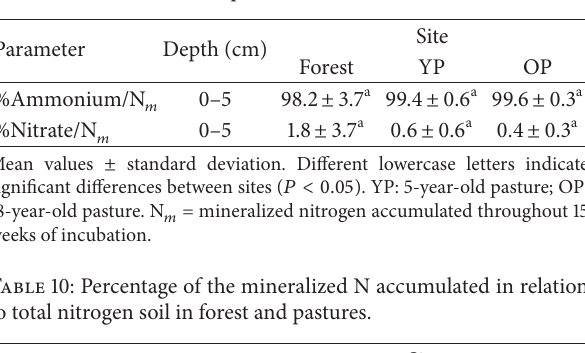
Table 9: Relationship between soil ammonium and nitrate in relationtothetotalmineralizedNaccumulatedthroughout15weeks of incubation in forest and pastures.